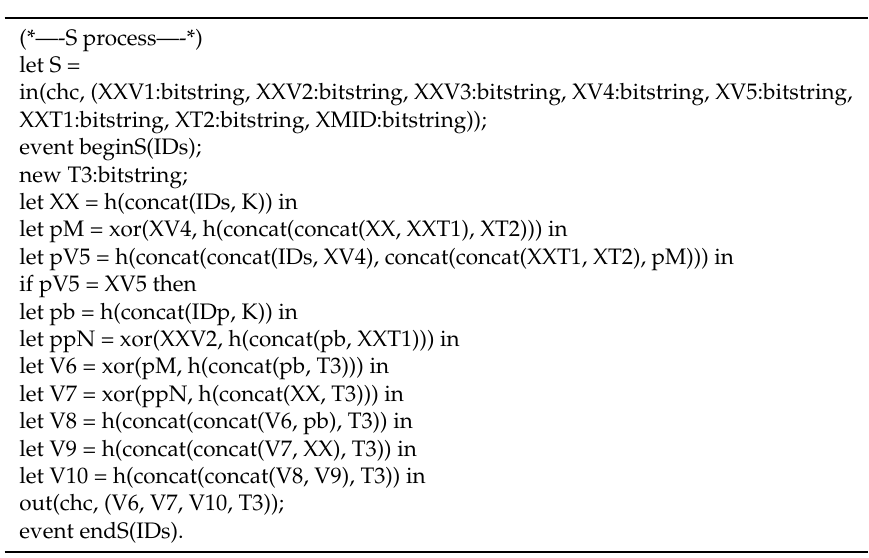
Table A4. Sensor